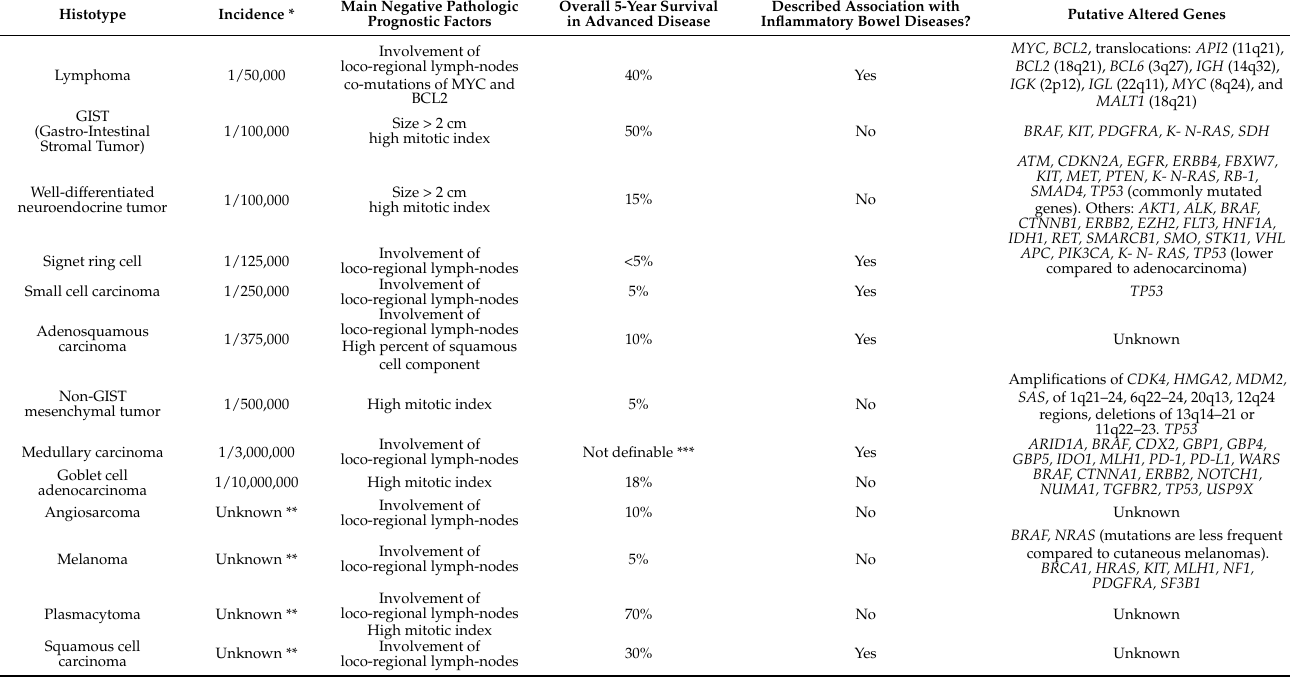
Table 1. Clinical, epidemiologic, and genetic information according to rare histotypes of colorec- tal